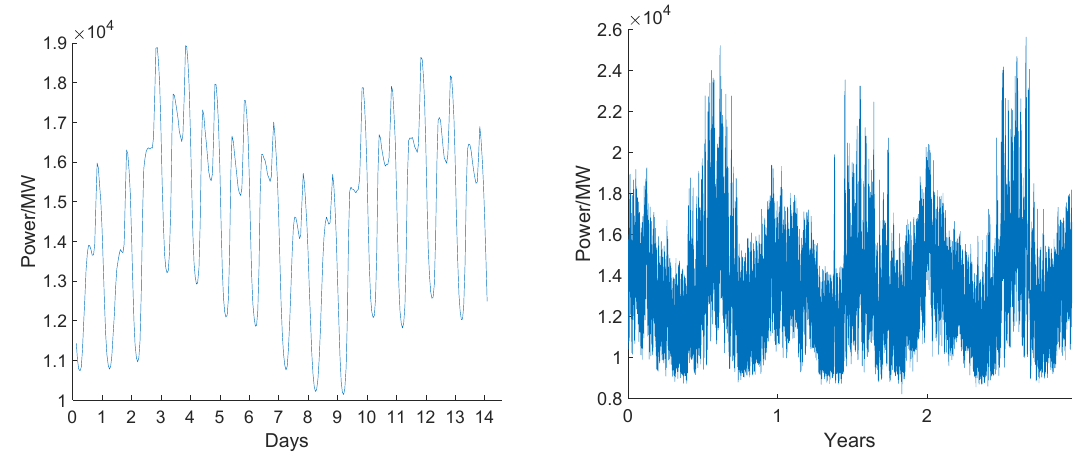
Figure 1. Yearly seasonality load profiles.